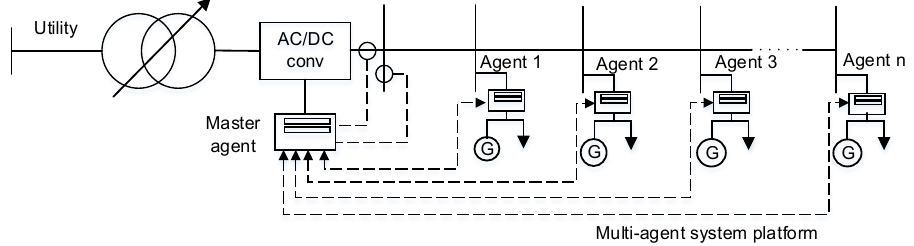
Figure 3. The structure of the proposed multi-agent system (MAS)-based voltage control system.